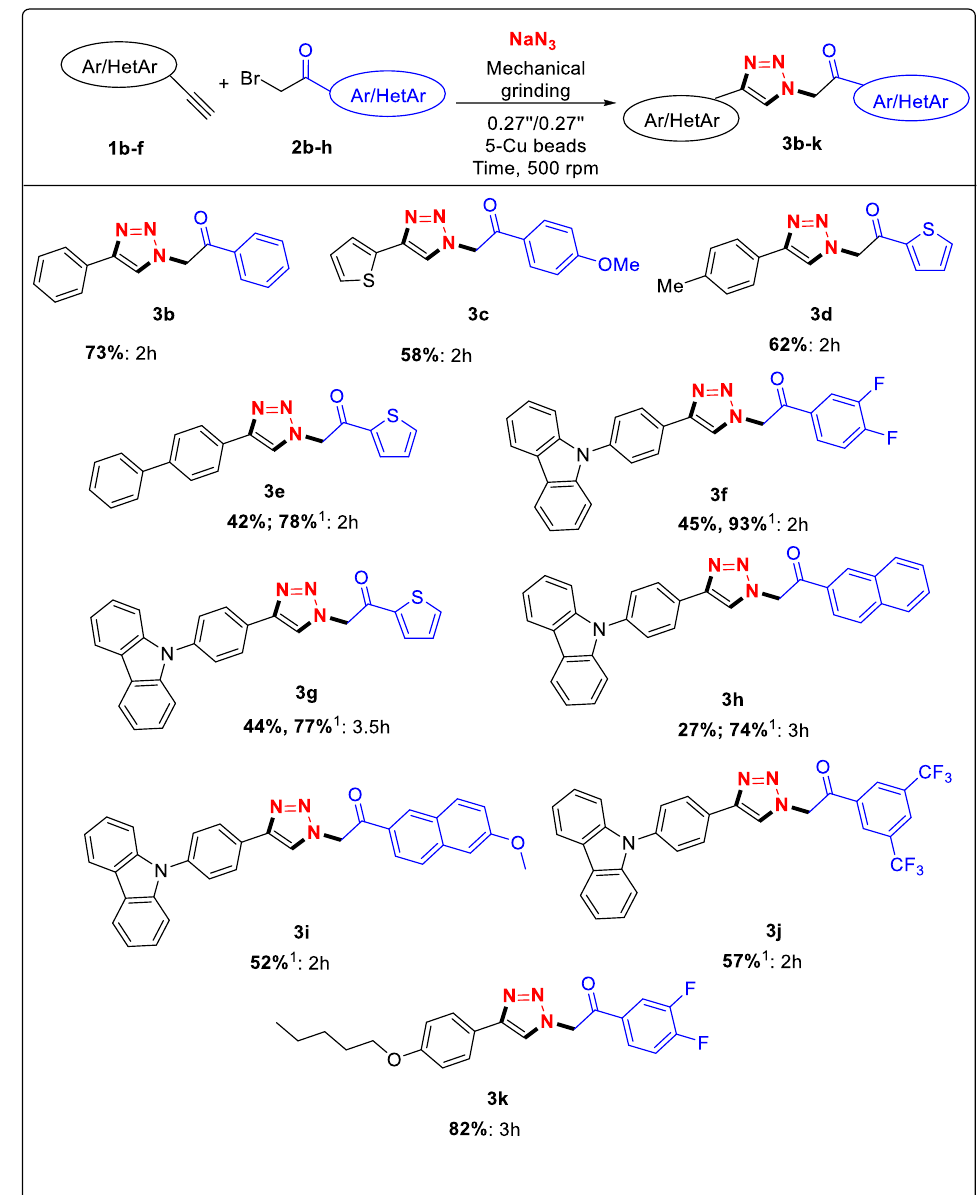
Figure 2. Scope of various alkynes and benzoylmethyl bromides in mechanochemical CuAAC reaction. Reaction conditions: Ar/HetAr alkynes 1b – f (1 equiv.), benzoylmethyl bromides 2b – h (1.2 equiv.), sodium azide (1.2 equiv.), 5-Cu beads, 500 rpm; 1 stepwise route.